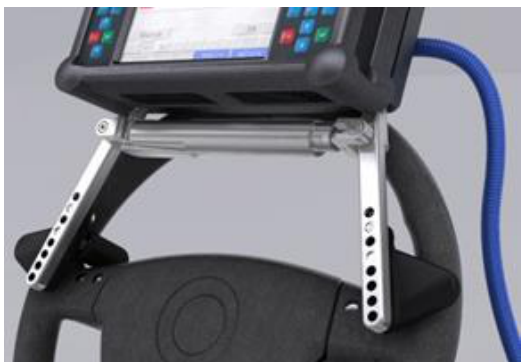
Figure 1. Attached steering wheel balance (DSA, 2016)